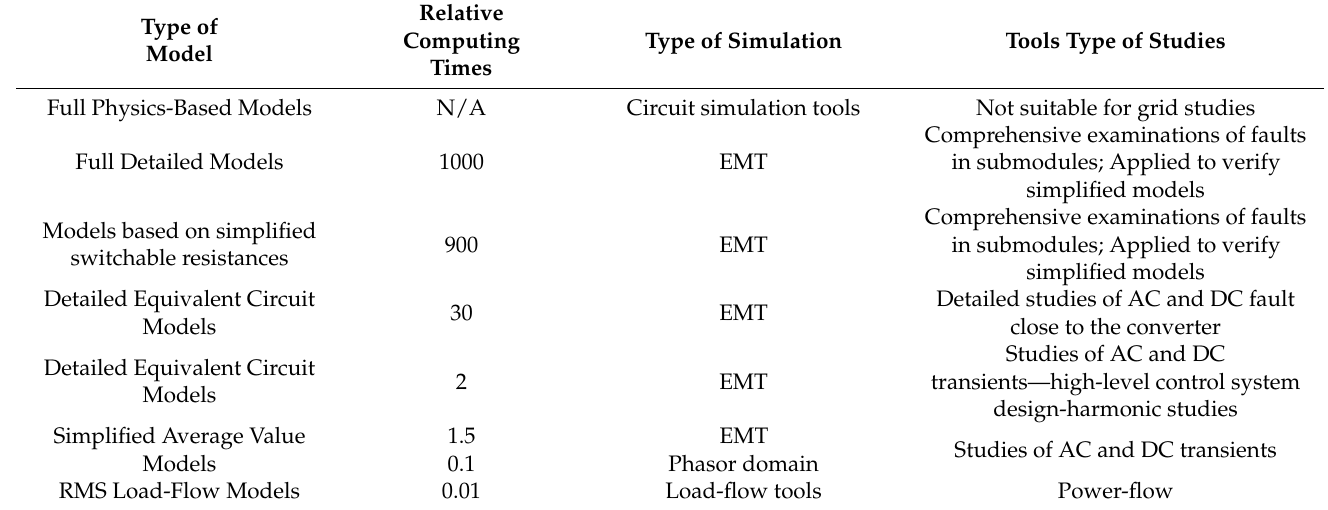
Table 2. Summary of various VSC